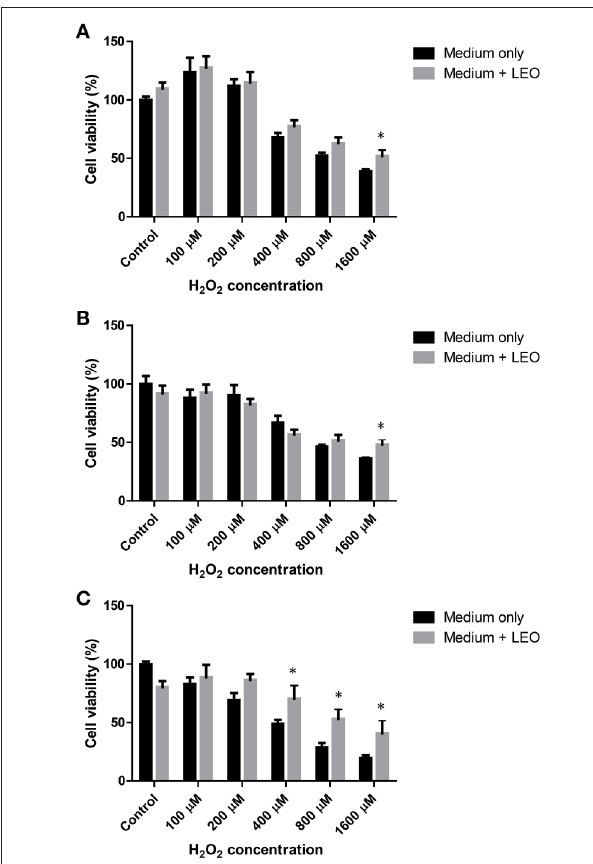
FIGURE 3 | Effect of 1 µ l/ml lavender essential oil (LEO) on hydrogen peroxide induced toxicity on SH-SY5Y cells at 0 (A) , 2 (B) ,and 24h (C) . * p < 0.05 vs. medium only.